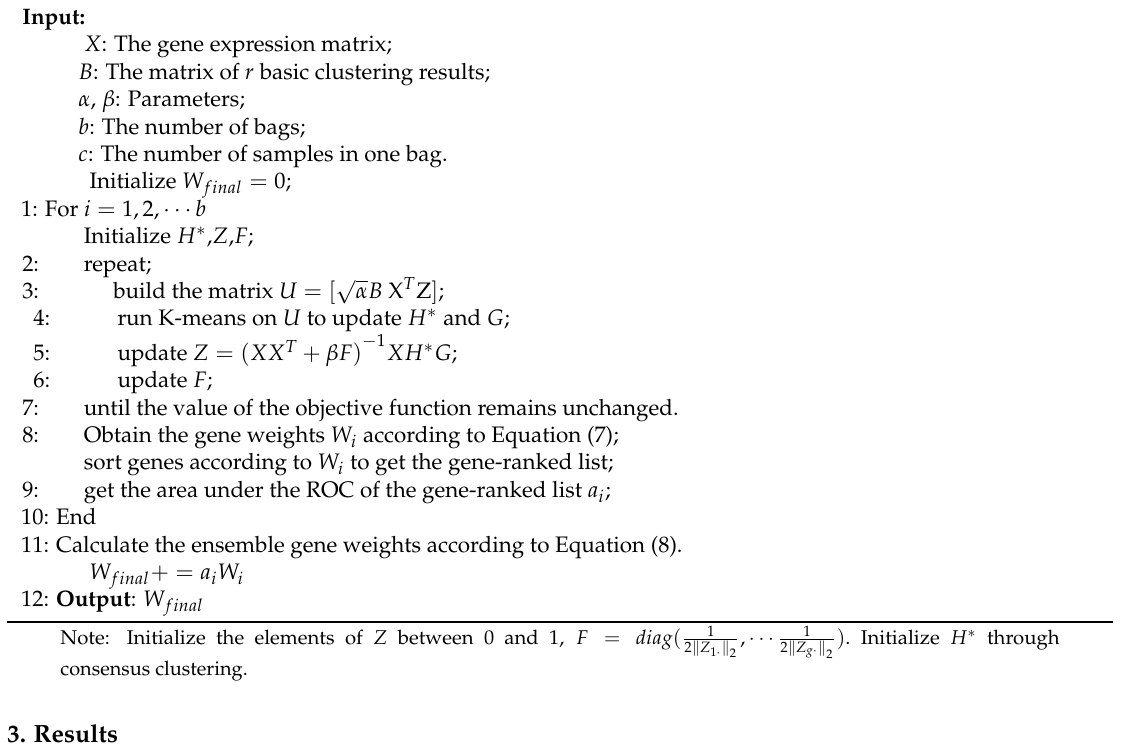
Table 1. Ensemble consensus-guided unsupervised feature